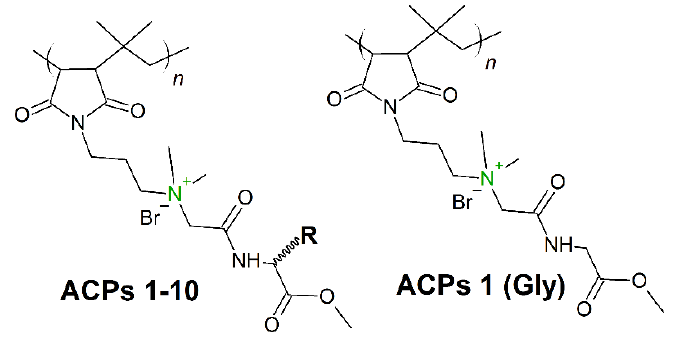
Figure 12. Schematic representation of 1-10 amino acid conjugated polymers (ACPs). In green: permanent cationic charge.